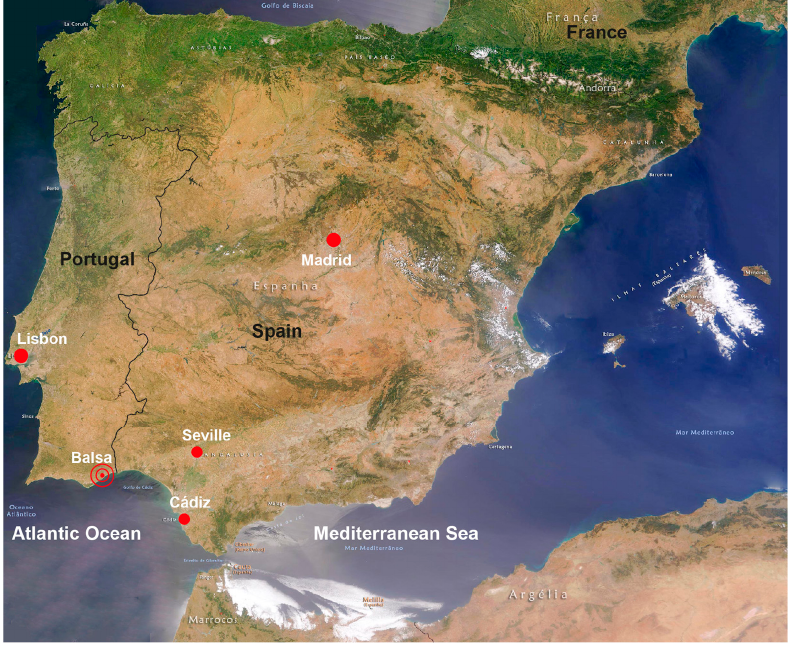
Figure 1. Location of Balsa, Luz de Tavira (Algarve, Portugal).